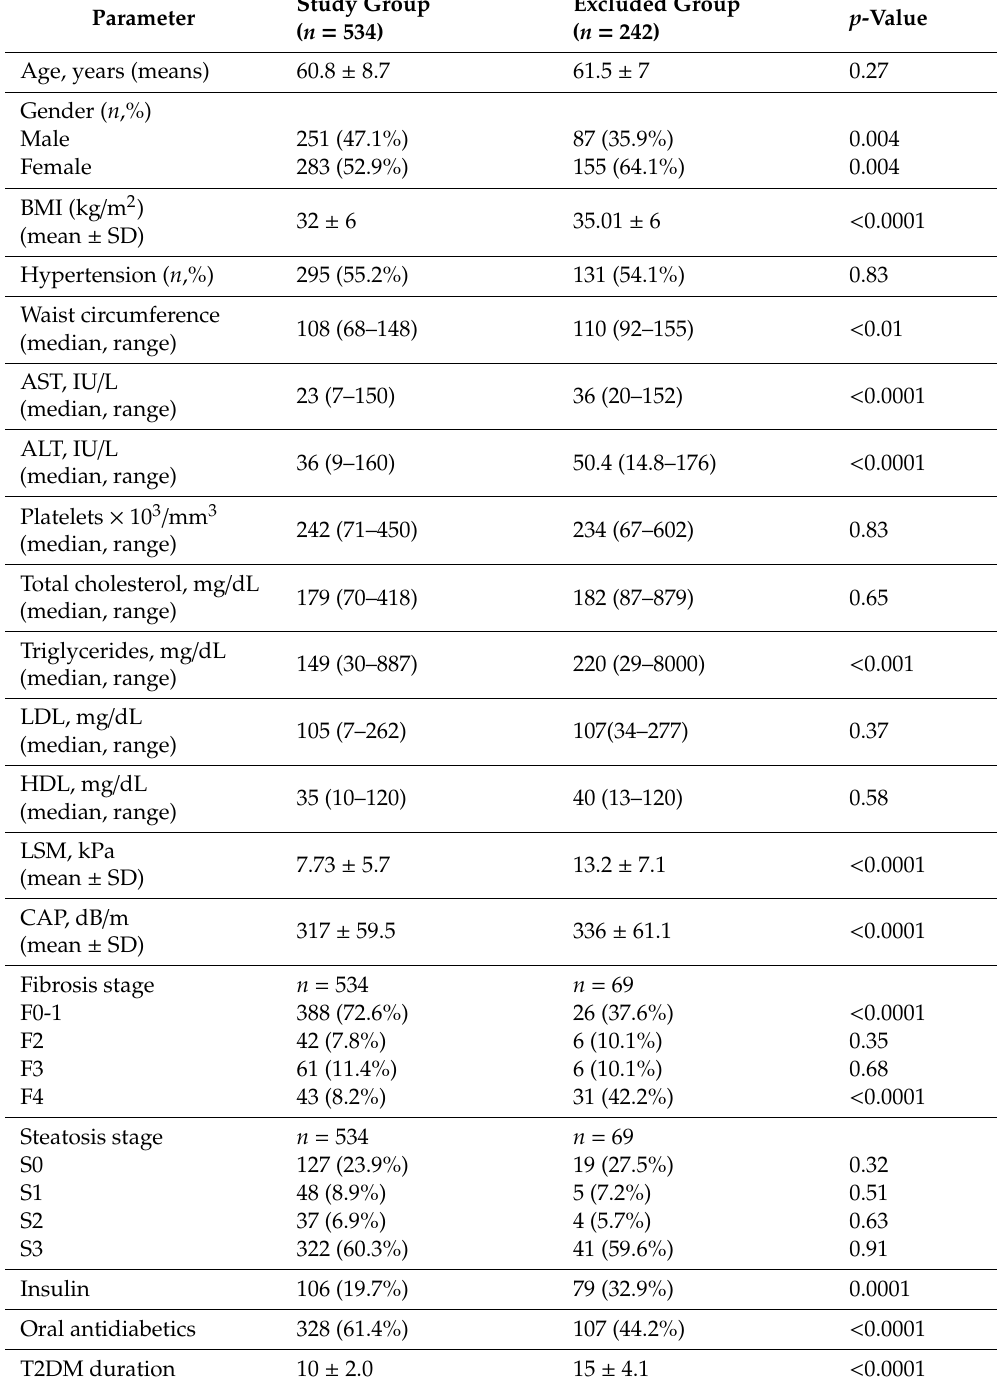
Table 1. Comparison between excluded patients and study